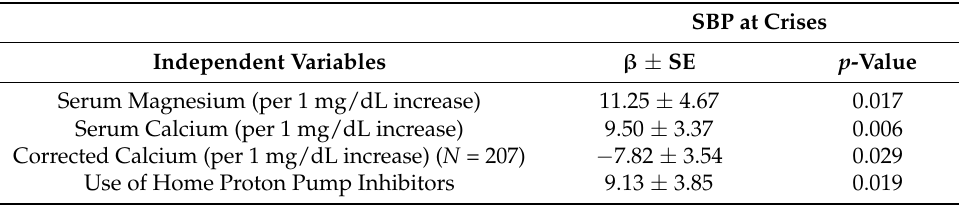
Table 4. Association of best independent variables with SBP at crises using linear model analysis (adjusted for covariates) ( N = 293).